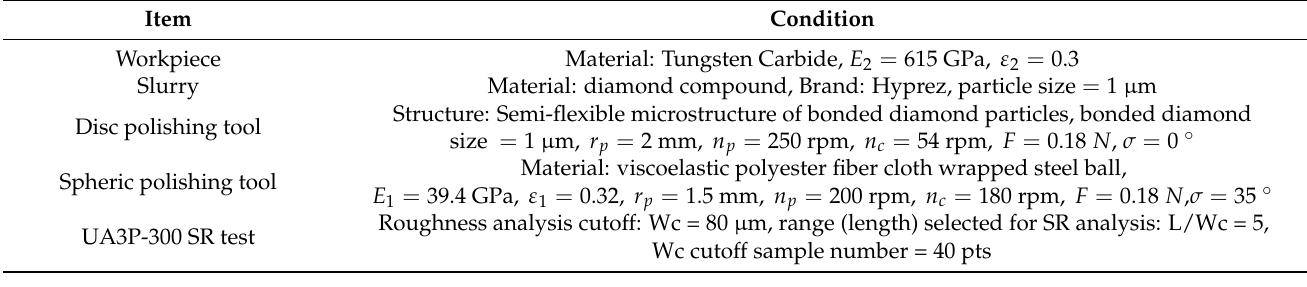
Table 1. Polishing and test conditions.